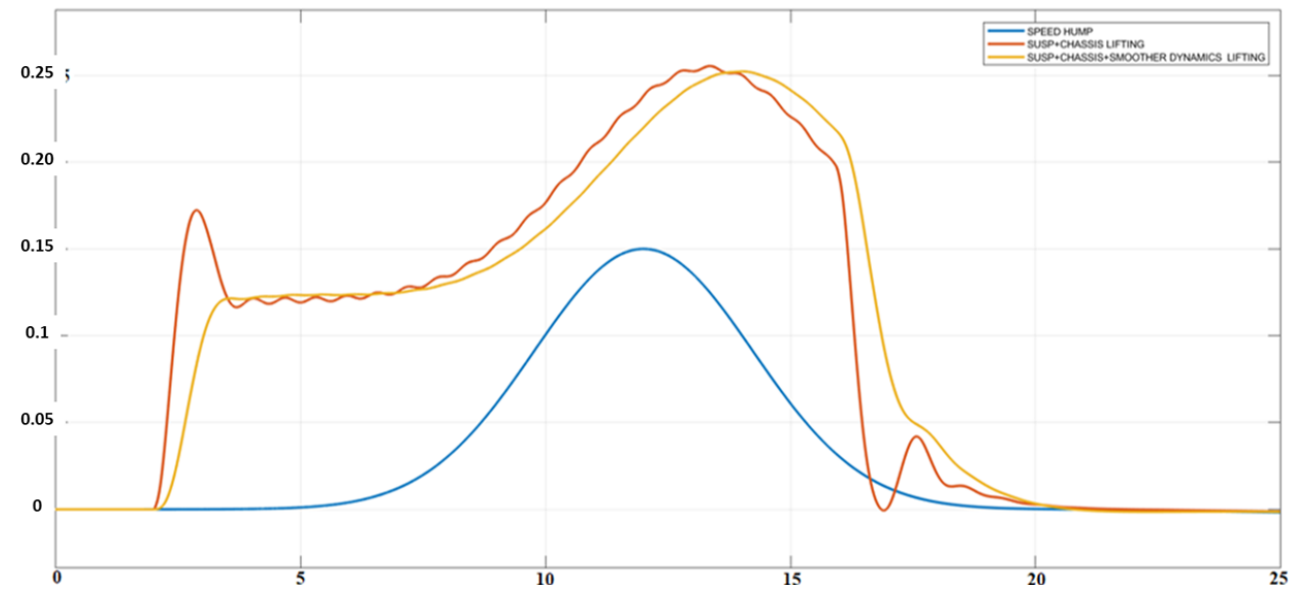
Figure 10. Positive reaction of the herein designed system against a Gaussian speed hump. In this image, the hump is illustrated. It starts at the 5th second and finishes at the 20th second, and the elevation is 15 cm. Notice that the original proposal exhibited an overshoot, but the ulterior improvement canceled this, as well as other undesirable oscillations.